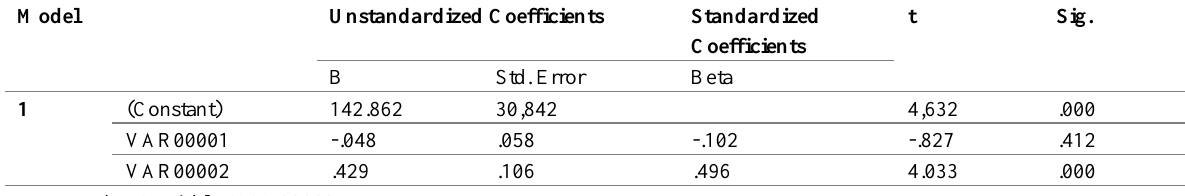
Table 7: T- Test Results Coefficients